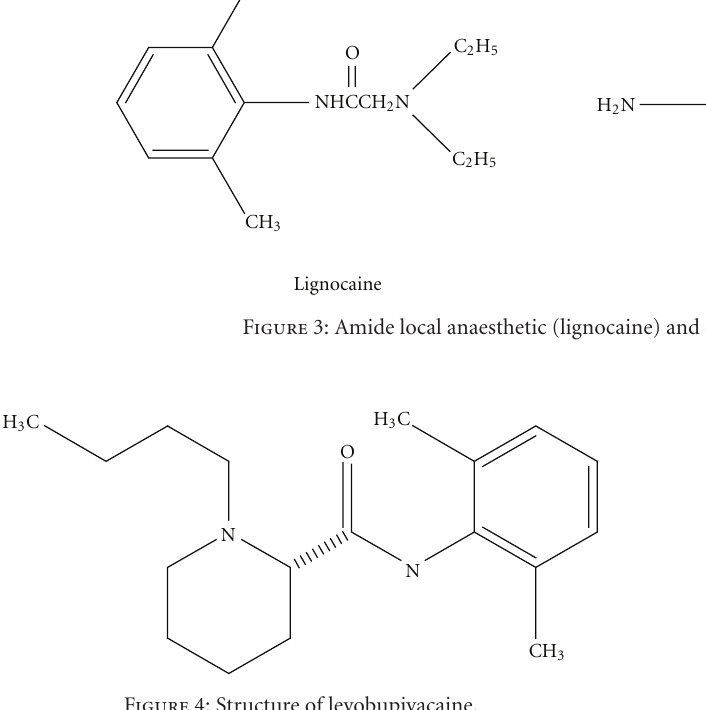
Figure 4: Structure of levobupivacaine.